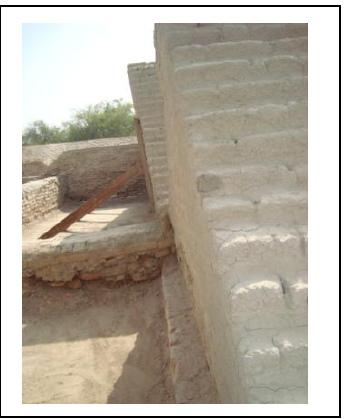
Figure 4: the view of the deformation (30 th March 2012,)